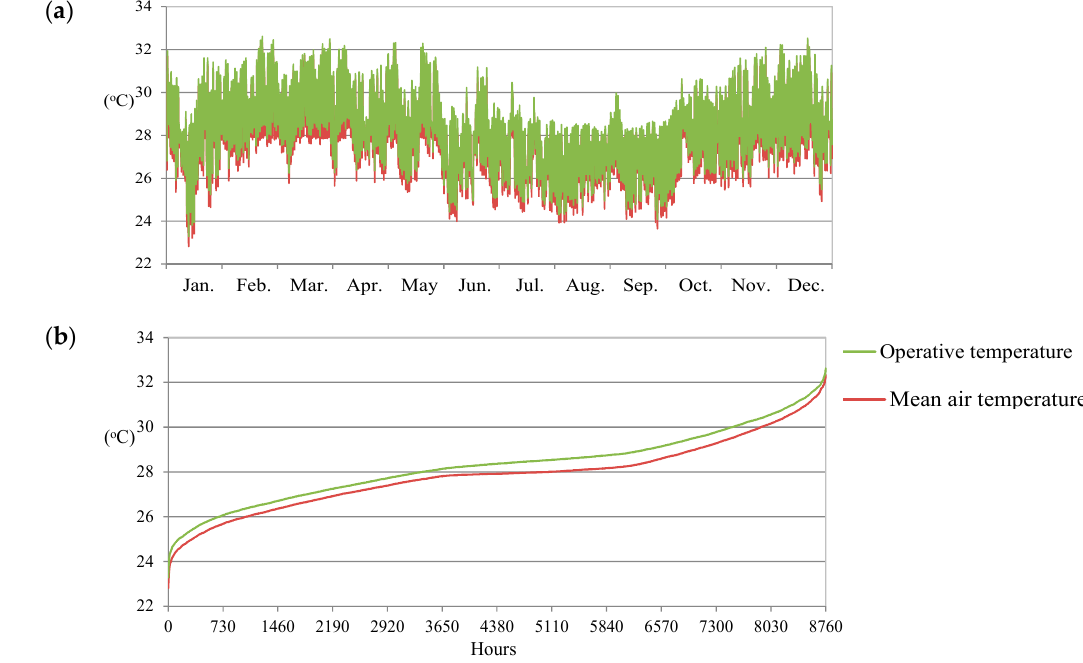
Figure 8. Annual hourly profiles of mean indoor air and operative temperatures for the living room simulated with the recent climate ( a ), and the same profiles arranged in ascending order ( b ).